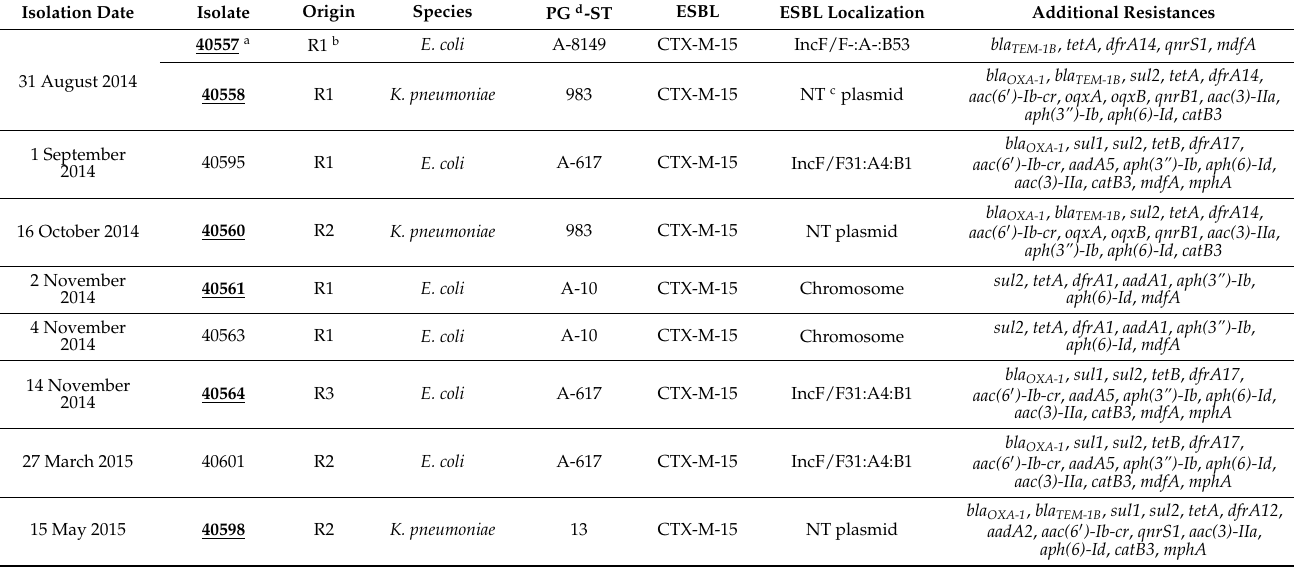
Table 1. Characteristics of isolates collected from fish.